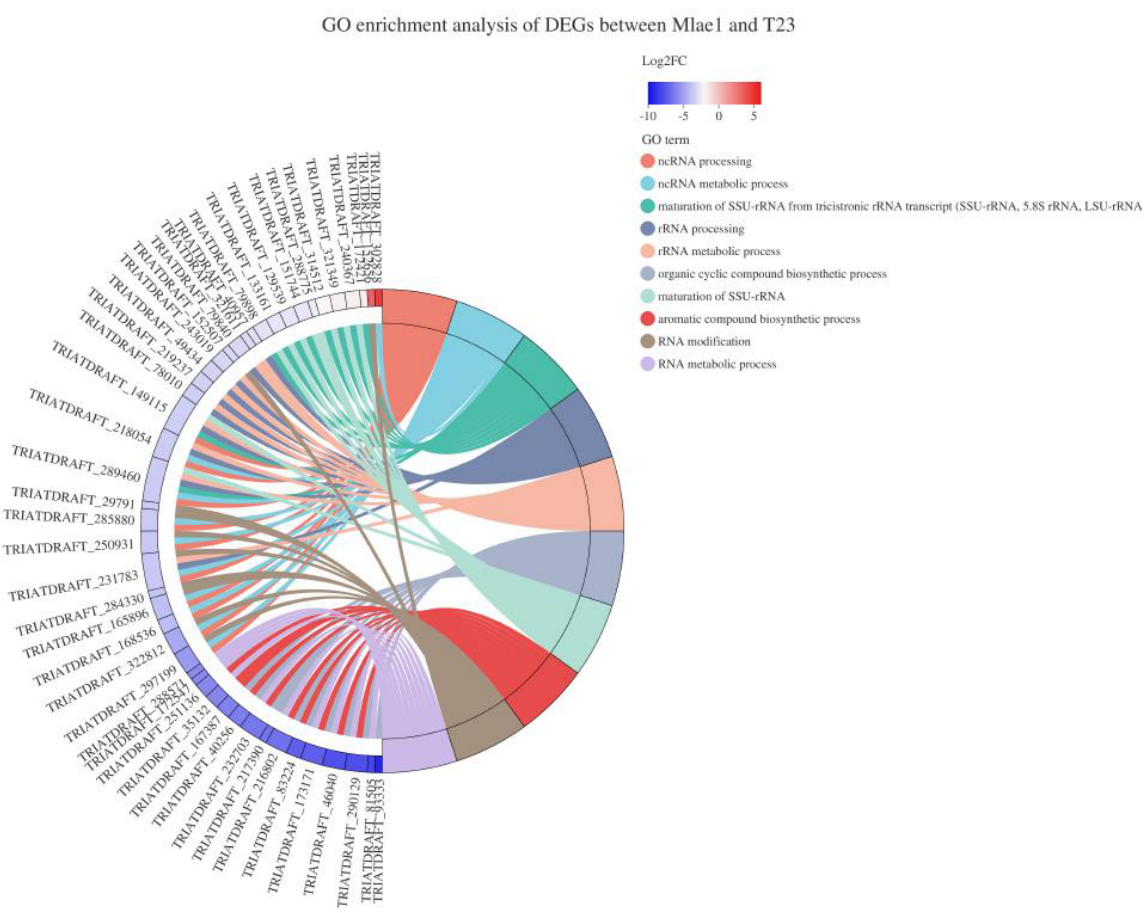
Figure 3. GO enrichment analysis of DEGs between Mlae1 and T23 strains.